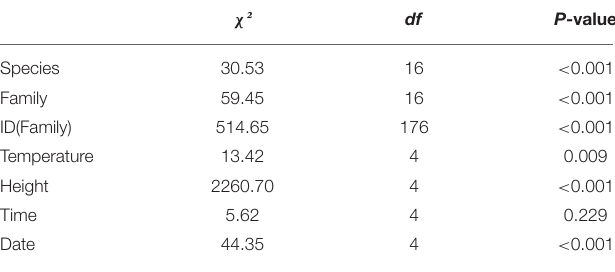
TABLE 3 | Results of the multinomial logistic regression to investigate variation in microhabitat use between the two species during the brumation experiment ( n = 2,055).